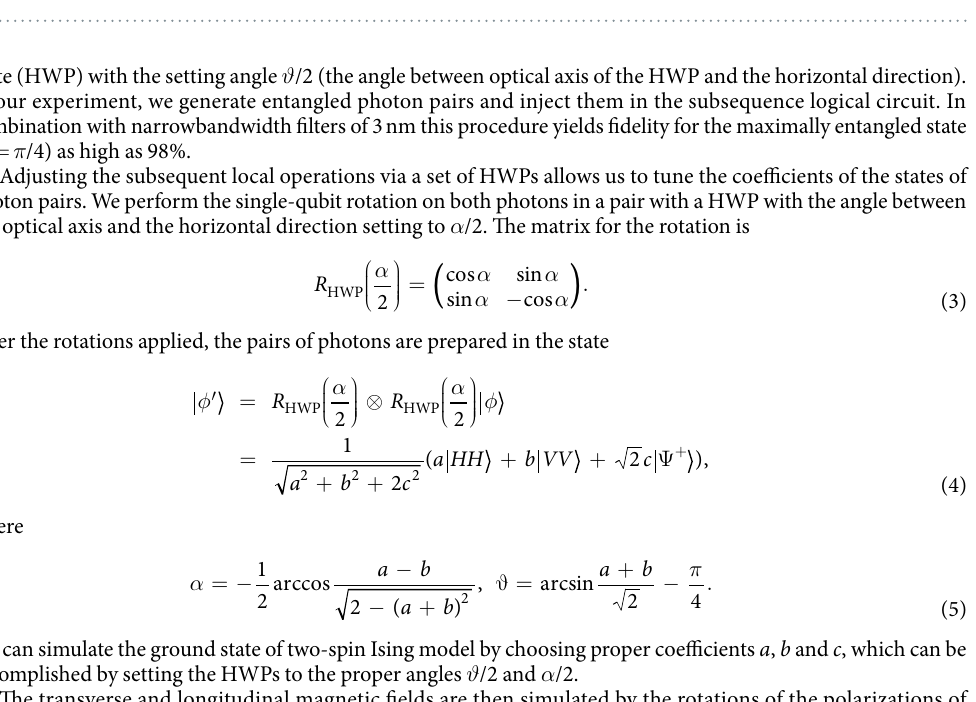
Figure 2. Experimental schematic. A 400.8 nm pump is directed injected through two 0.5 mm-thick β - BBO crystals, giving rise to pairs of correlated photons at 801.6 nm. Photon pairs are detected via APDs and fast coincidence electronics. Quartz plates (not shown) and α -BBO crystals are used to compensate the birefringence of the β -BBO crystals. The following HWP is used to adjust the relative phase of entangled photon pairs. The simulated ground state of the two-spin Ising model changes from a ferromagnetically ordered high-field states to an anti-ferromagnetic low-field states via tuning the setting angles ϑ /2 and α /2 of the corresponding HWPs. A two-photon tomography of the output allows reconstruction of the simulated ground